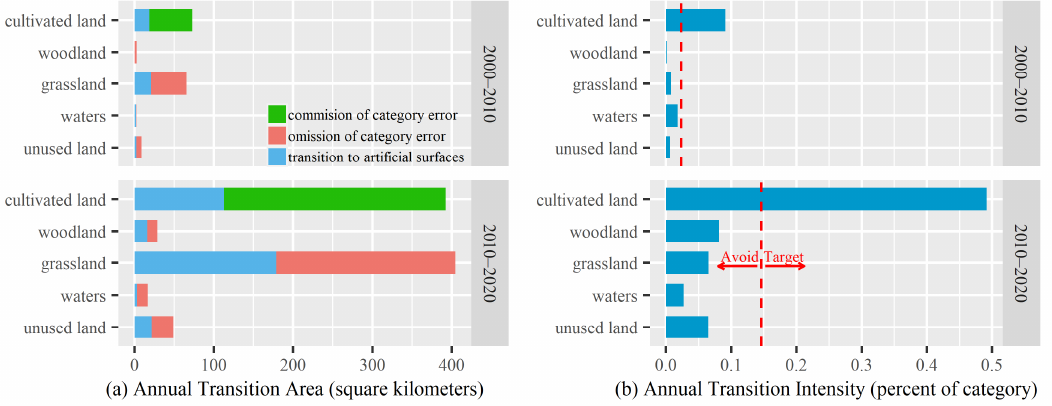
Figure 13. Intensity analysis for transition to artificial surfaces for the upper reaches. The transition size along with hypothetical map errors ( a ); transition intensities ( b ). The red, vertical dashed lines indicate the uniform intensities.